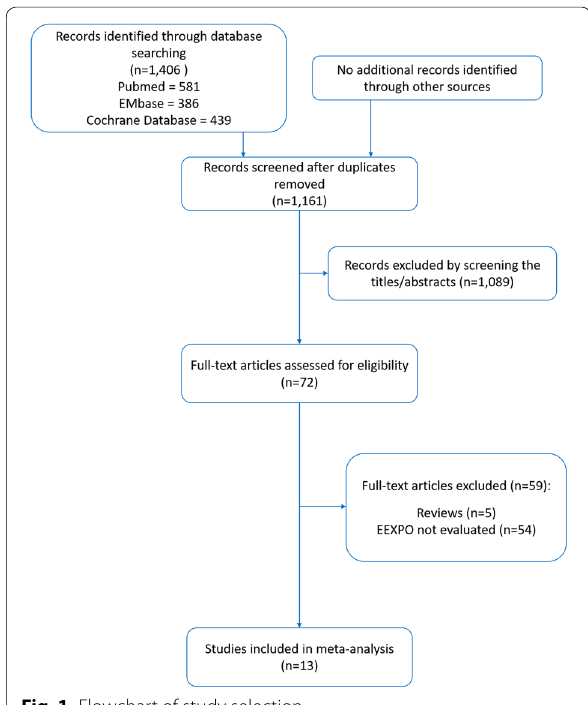
Year No. Setting PEEP (cmH 2 O) Tidal volume (mL/ of patients